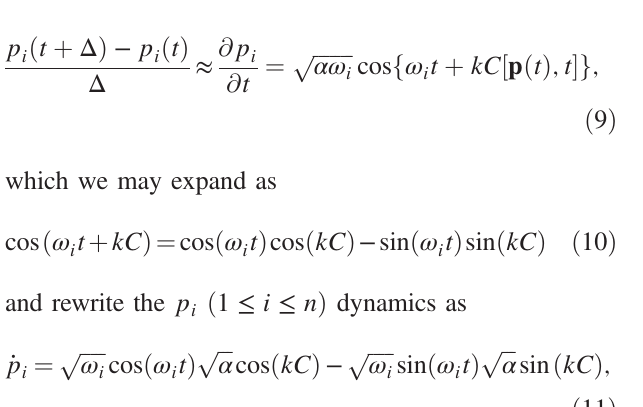
FIG. 4. Convergence of the L i T rack spectrum to the actual, time-varying spectrum for a fixed rms-width